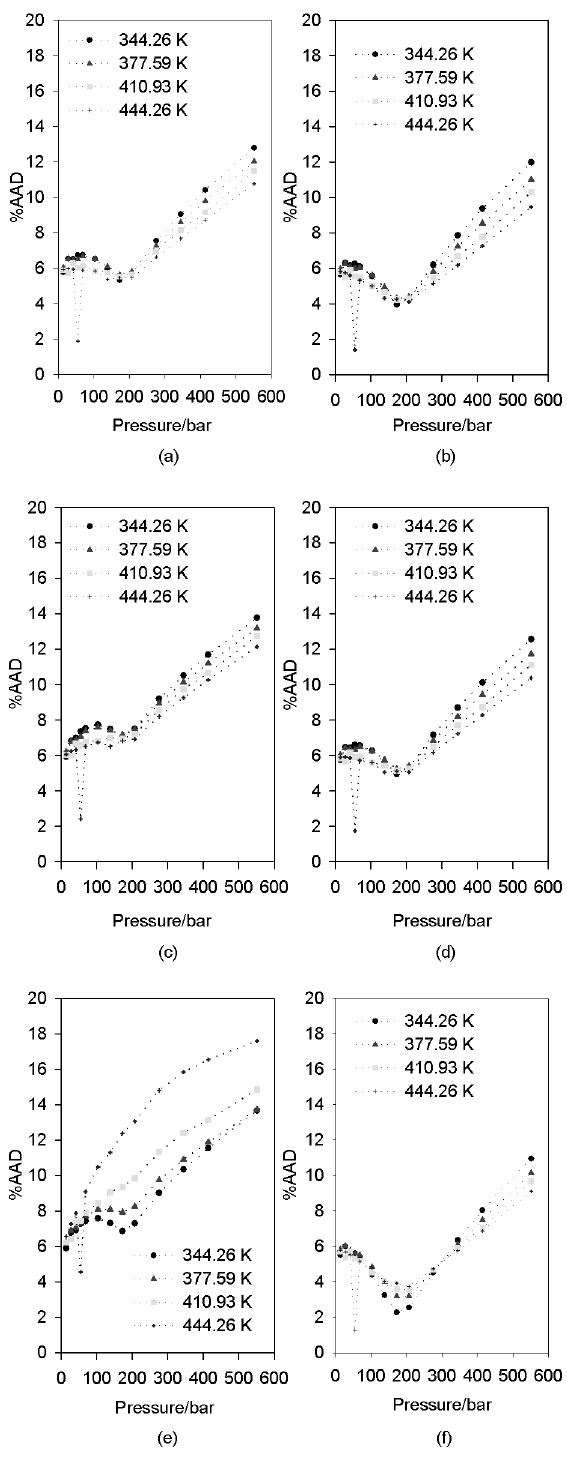
Figure 2. Volume deviations (%AAD) of mixture GN1 calculated with the models PR with non-zero BIPs (a), Coquelet (b), Saffari-Zahedi (c), Mathias-Copeman (d), Gasem (e) and extended Saffari-Zahedi